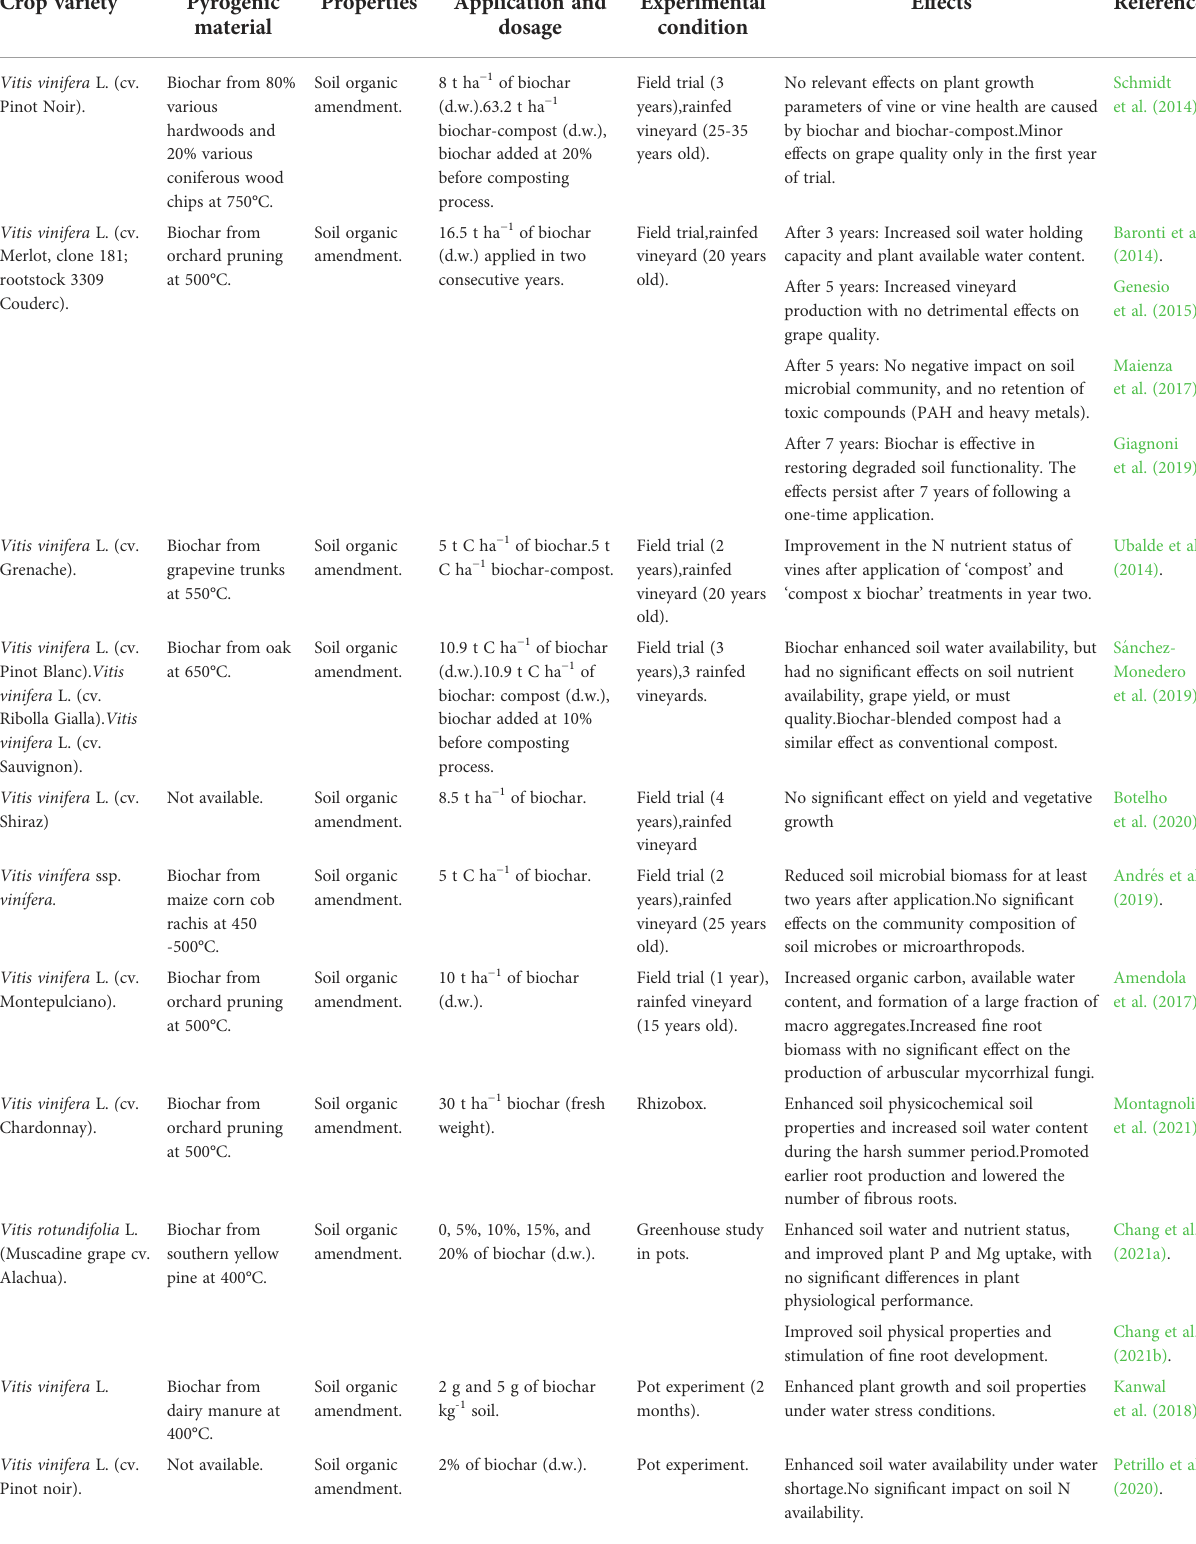
TABLE 4 An overview of the main effects of pyrogenic materials in